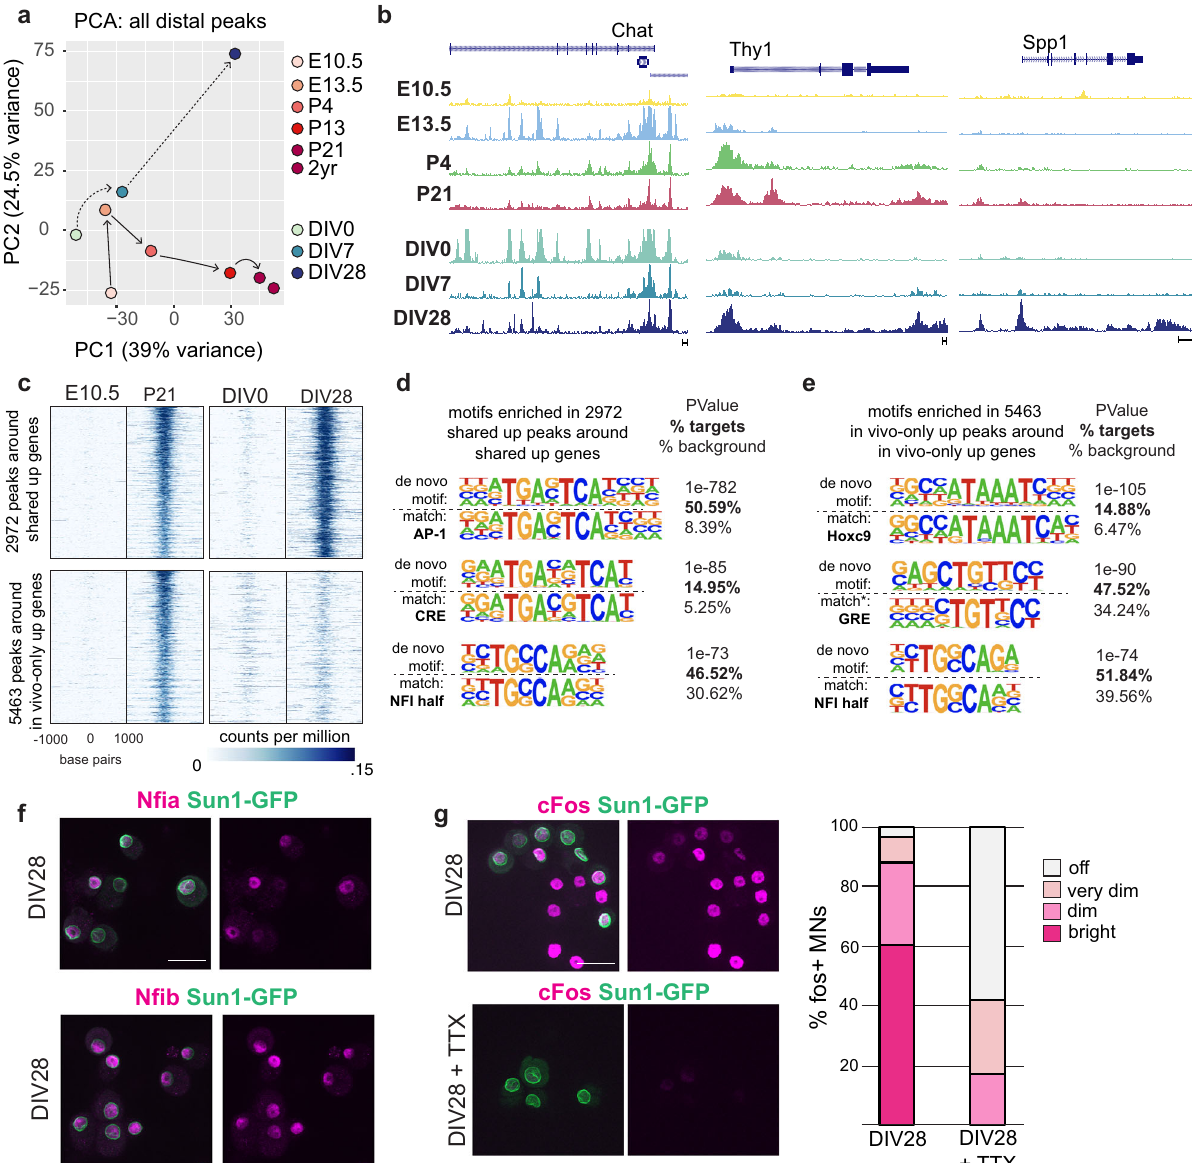
Fig. 5 | Identi fi cation of shared and in vivo-speci fi c regulators of maturation. a Principal component analysis on in vivo and in vitro datasets based on all distal ATAC-seq peaks. Each circle is the cumulative ATAC-seq data from two biological replicates. b ATAC-seq reads around a continuously expressed gene ( Chat ) and genes upregulated during maturation ( Spp1 and Thy1 ). c Heatmaps of ATAC-seq reads. Each panel spans ±1kb from the center of peaks. Top: peaks upregulated both in vivo and in vitro around shared upregulated genes. Bottom: peaks